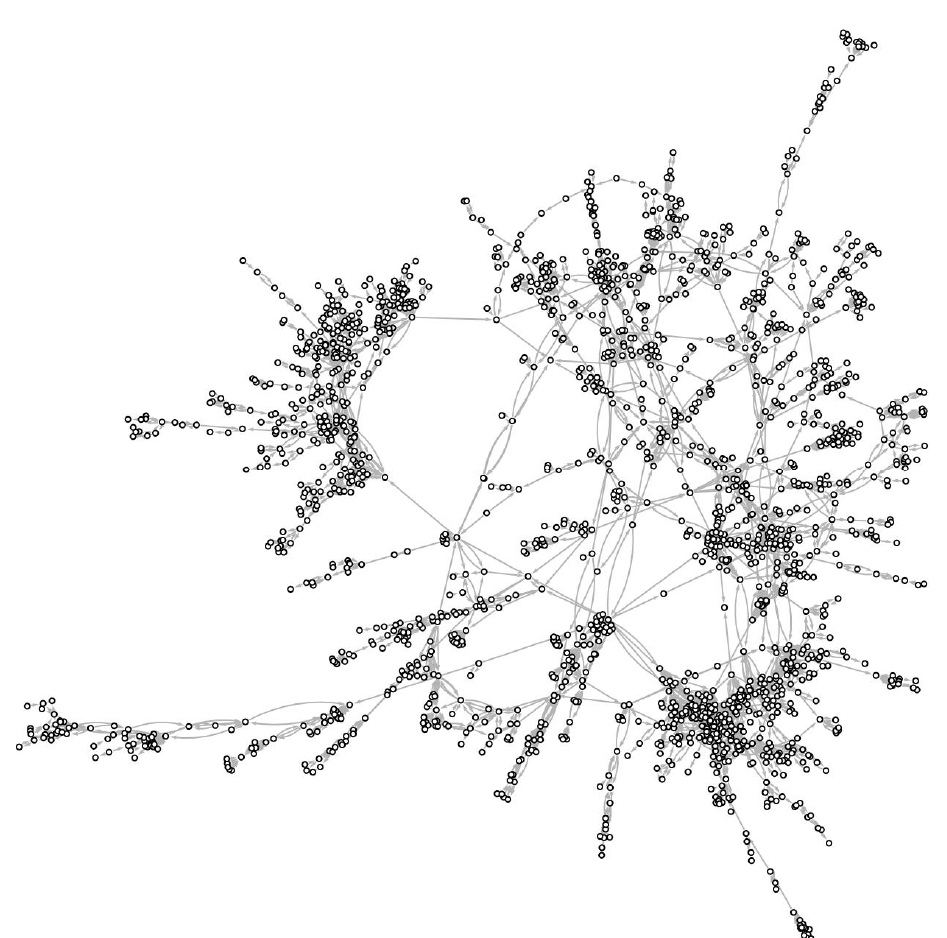
Figure 10. Supply Chain for 34 days from 1st June 2021. Largest component only. Standard member and chama nodes only.